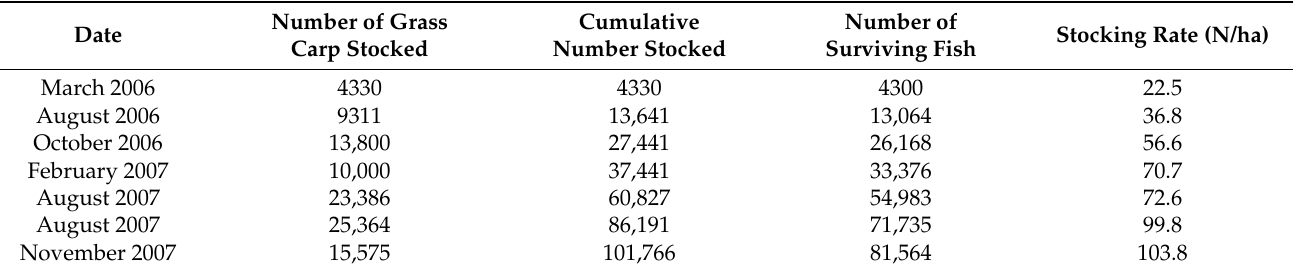
Table 2. Summary of the scheme used to stock grass carp into Lake Conroe from March 2006 to November 2007, including the cumulative numbers stocked and the estimated cumulative stocking densities [28]. Numbers of fish surviving were calculated based on an estimated annual mortality rate of 32%